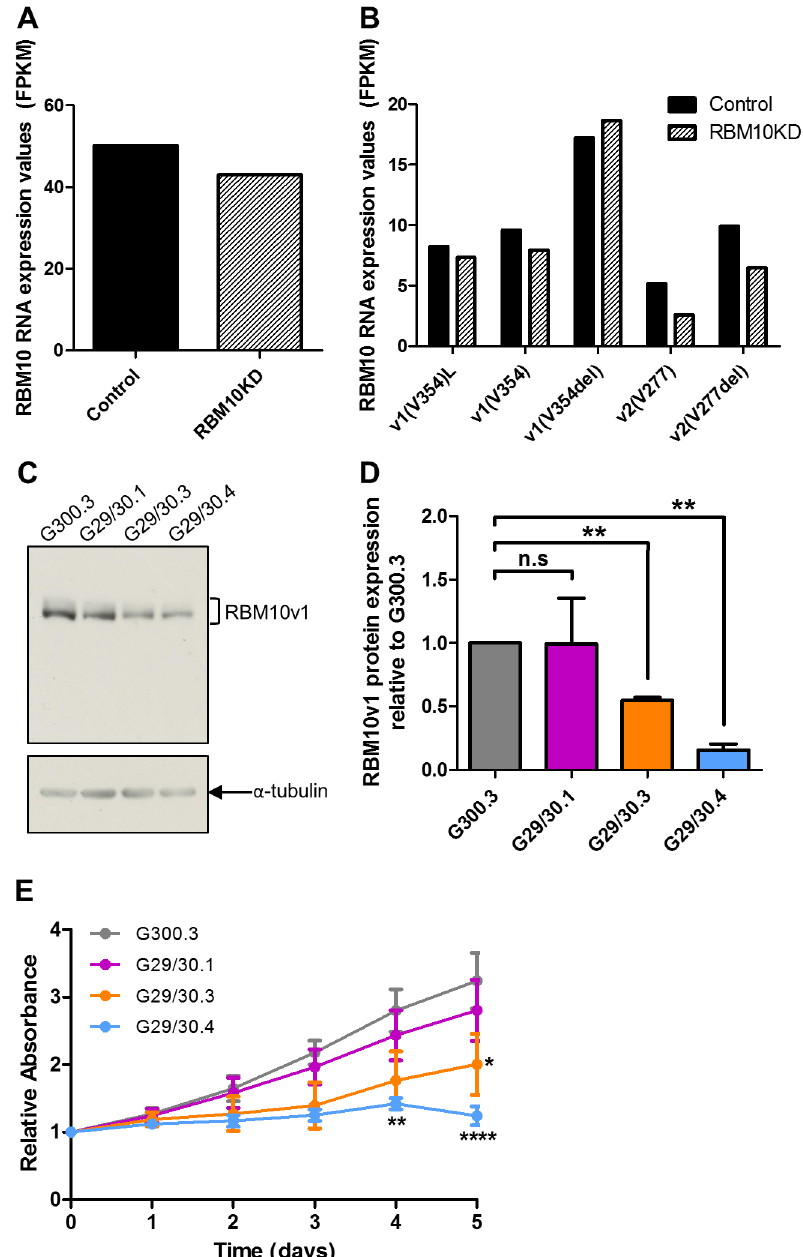
Fig 3. RBM10 expression and dehydrogenase activity in control and stable RBM10 KDGLC20 sublines. (A & B) RBM10 mRNA levels, determined by RNA-Seq, for all RBM10 variants combined(A) or for individual splice variants (B). ‘Control’representsvalues from parentalGLC20 cells and the control G300.3 GLC20 subline. RBM10KDsample used was the G29/30.4 subline, as it showedgreatest decreasein RBM10 protein expression. (C & D) RBM10v1 protein levels were monitoredin the G300.3, G29/30.1, G29/30.3 and G29/30.4sublinesusing the Bethyl RBM10 antibody. (C) One representative Western blot result is presented for RBM10v1 and α -tubulin(loadingcontrol). (D) Densitometric results of the averageRBM10v1 protein levels from three biologicalreplicatesperformed in duplicate. Analysis was performed using the AlphaEaseFC, ‘1D-Multi’analysistool. Valuesof RBM10v1 were normalized to the α -tubulinof each biologicalreplicate, and then made relative to the G300.3 control subline.Standarderror is presented. Sublineexpressionlevels were comparedusing the Student’s unpaired t -test, betweensublines.(E) G300.3, G29/30.1, G29/30.3 and G29/ 30.4 were grown for five days and dehydrogenase activity was monitored daily using an MTT assay. Absorbance was plotted relativeto day 0. The averageof three biological replicates performed in eight